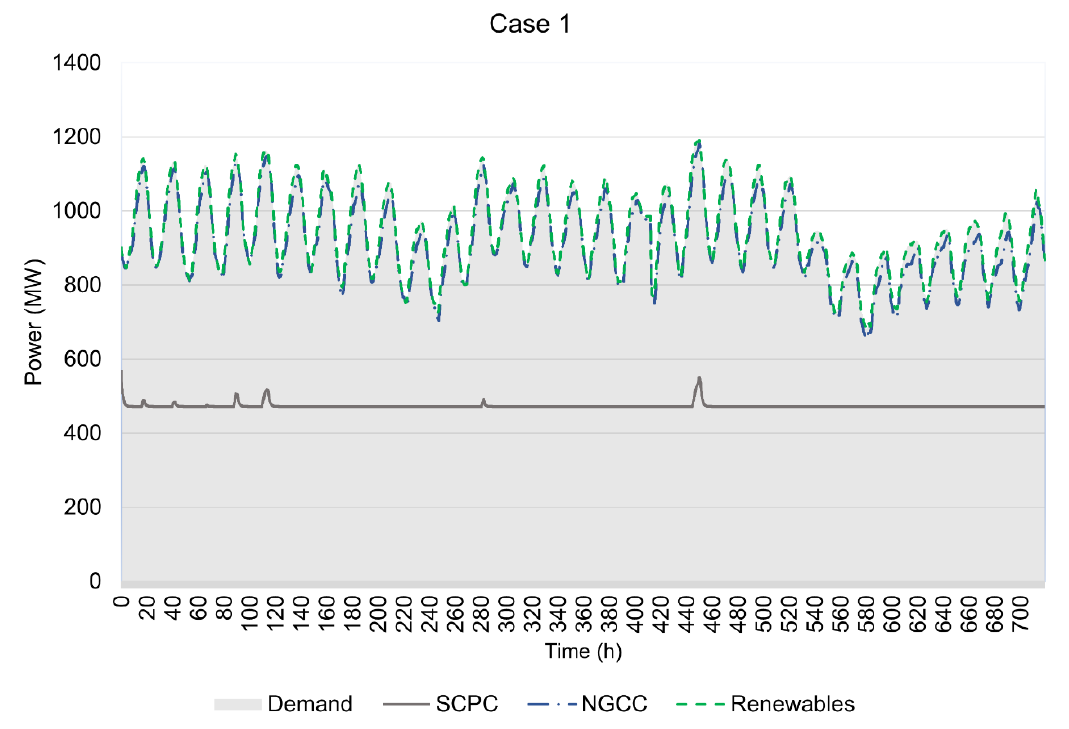
Figure 9. Power dispatch optimization result for Case 1.